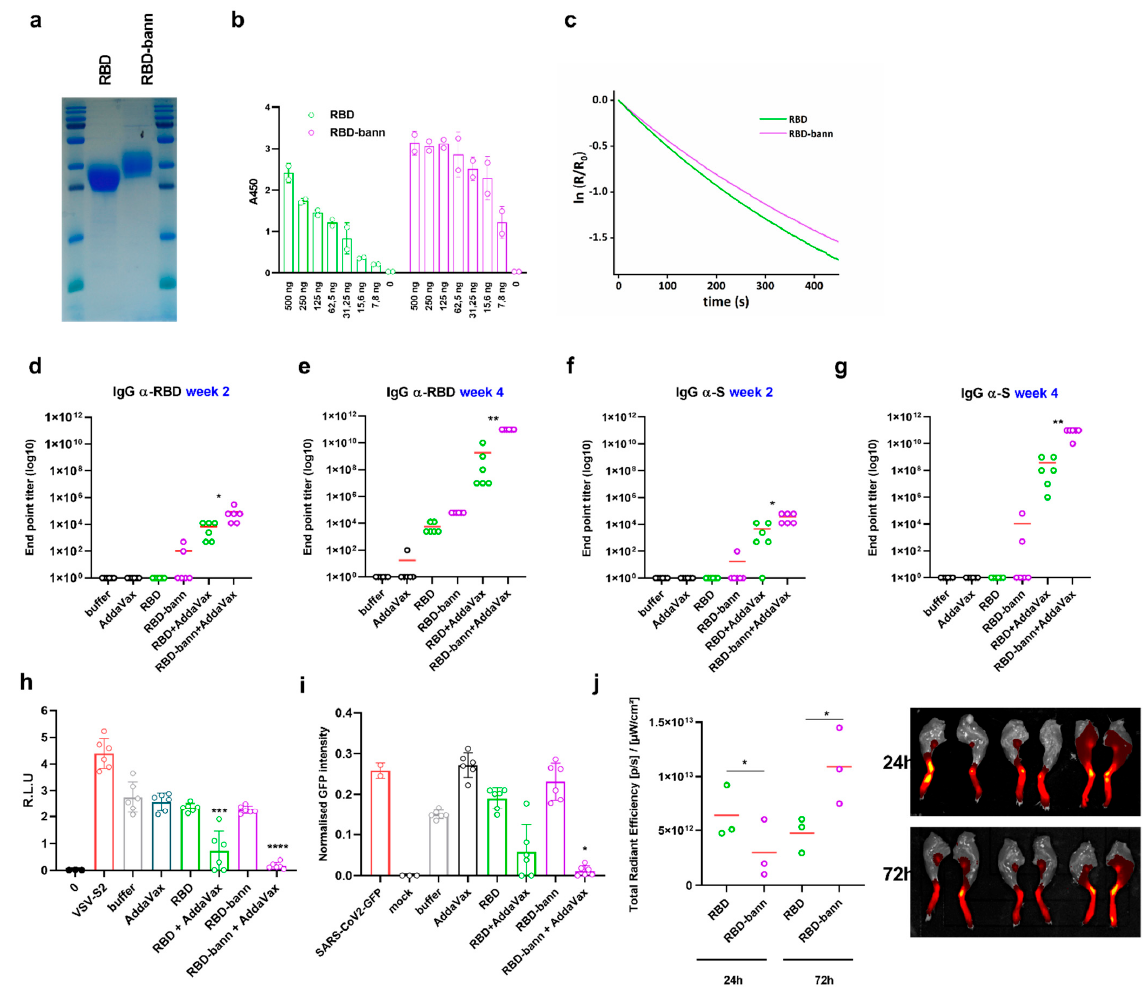
Figure 5. Augmented antibody titer, viral neutralization, and lymph node retention of RBD-bann protein vaccine. RBD variants were isolated from the supernatants of mammalian cells via affinity chromatography and analyzed for purity and specificity via SDS-PAGE ( a ) and the binding of recombinant proteins at a serial dilution, or buffer alone (0), to immobilized human ACE2 receptor was measured in an ELISA assay ( b ). Dissociation of RBD and RBD-bann from immobilized hACE2 was measured by SPR ( c ). Mice were immunized with RBD and RBD-bann proteins purified from mammalian cell supernatant with/without squalene-mediated adjuvant. End point titer (EPT) for total IgG against RBD ( d – e ) and against spike protein ( f – g ). Graphs represent the mean EPTs of groups of mice ( n = 6 per group). Each dot represents an individual animal. * p < 0.05; ** p < 0.01. All p values are from the Mann–Whitney test compared to RBD group + AddaVax. Neutralization titer in mice sera was determined using a pseudovirus system. Sera of mice immunized with isolated proteins were diluted 50-fold, and Spike-pseudotyped virus infection of ACE2 and TMPRSS2-transfected HEK293 cells was followed by luminescence. Mean and SEM biological replicates are shown ( b ). * p < 0.05, *** p < 0.001, **** p < 0.0001. All p values are from one-way ANOVA followed by Tukey’s multiple comparisons test compared to the buffer group ( h ). A serum virus neutralization assay was performed by infecting Vero E6 cells with SARS-CoV-2-GFP reporter virus (MOI 1) with prior incubation of inoculum with dilutions of mouse sera (1:50) immunized with indicated isolated proteins. As control cells were left uninfected (mock), GFP signal was measured 36-h post-infection using the Incucyte S3 live-cell imaging system. Each point represents the mean of two technical replicates, and the mean +/ − SD from six mice per group is indicated. Indicated p -values apply for comparison between individual conditions and the dilution-matched buffer condition and were calculated using a one-sided Student’s t -test between RBD + Addaax and RBD-bann + Addavax. * p < 0.05 ( i ). Trafficking of labeled isolated proteins into the popliteal lymph nodes (PLN). AF-647 labeled RBD proteins were injected into the foot pad (RBD left, RBD-bann right). The fluorescence signal of AF-647 was determined in the popliteal lymph node, depicting the presence of labeled RBD. Each dot represents the measurement of the region of interest (ROI) of an individual animal PLN. * p < 0.05 derived from two-tailed paired t -test ( j